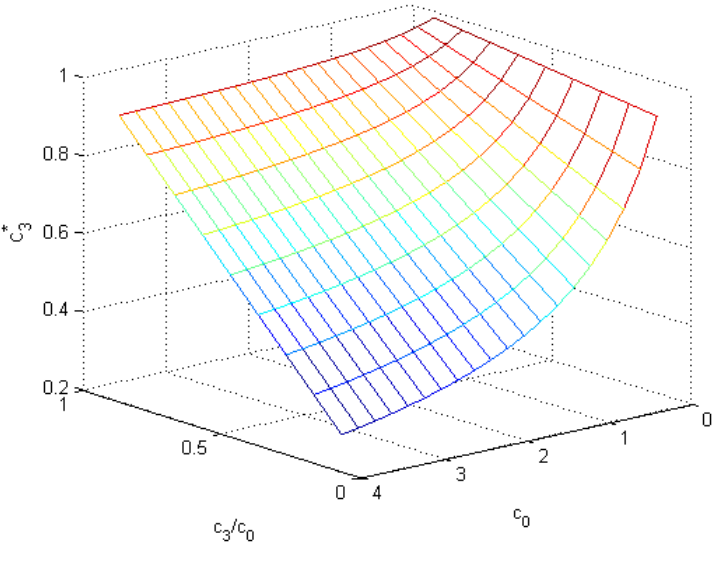
versus c 0 and the ratio c 3 3